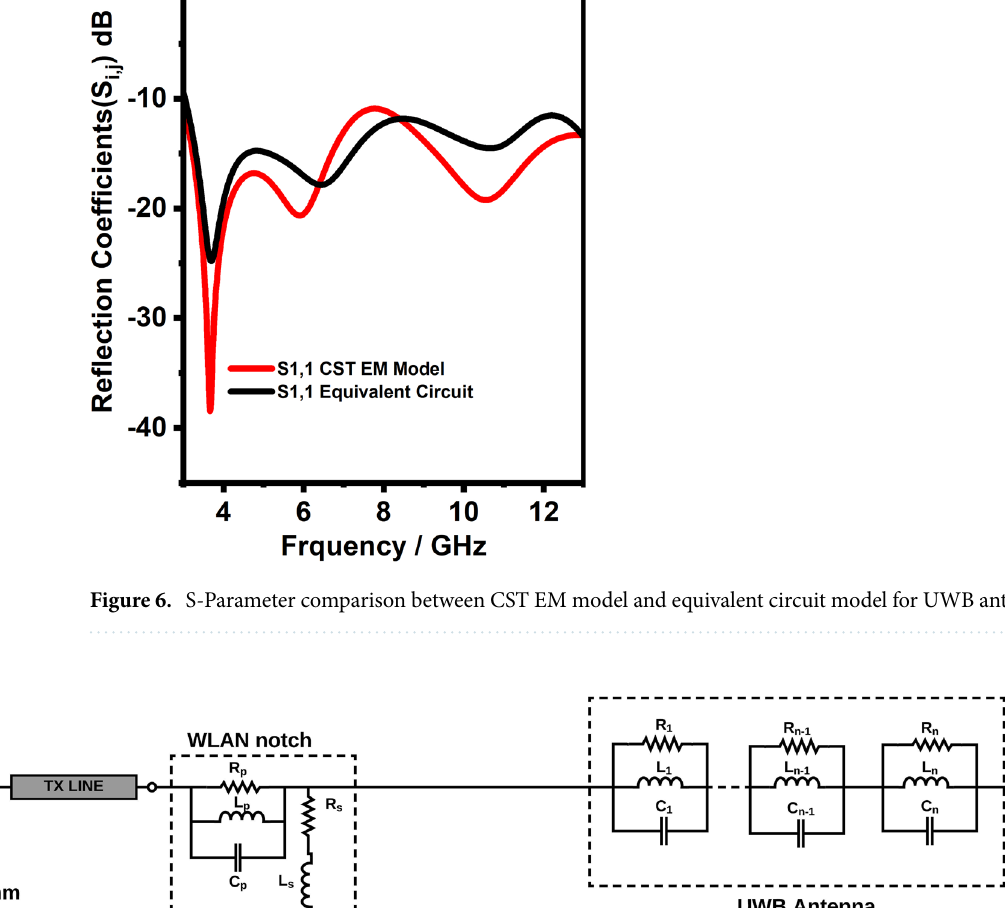
Equivalent circuit of folded L‑shaped stub notch resonators (ITU‑band notch). For the ITU fre- quency band, at 8 GHz, the real impedance is 200 (cid:31) . Also, the imaginary value of the impedance varies from +ve to −ve value at 8 GHz. The equivalent circuit for the ITU band notch resonator consists of a series and parallel combination RLC components. The lumped equivalent circuit model of ITU (8 GHz) band notch filter is shown Fig. 8. The optimized lumped elements (R, L, C) values shown in Table 2. It can be seen from Fig. 9 the EM model and the lumped circuit model S-parameters are almost the same. Also, it is witnessed that at the notch band the S11 is greater than − 2 dB for both EM model and equivalent circuit model due to impedance mismatch. Equa- tion (7) used to achieve band notch at WLAN band. Hence, it is clear from the reflection coefficient the ITU band notch is effectively achieved by using a two L-shaped slot.